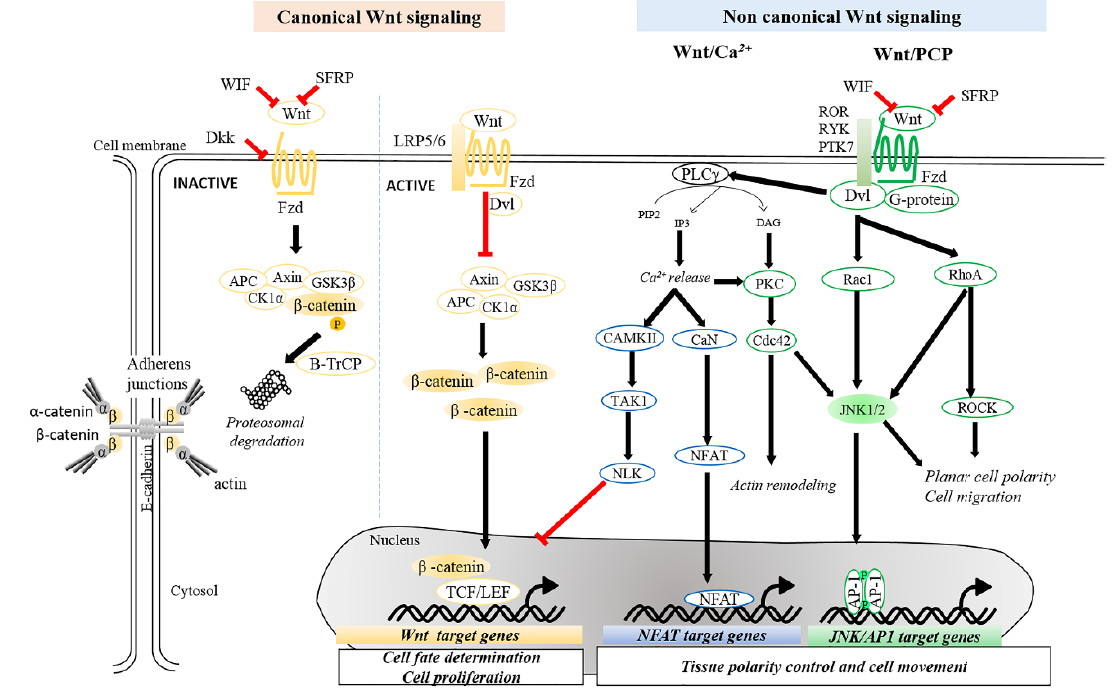
Figure 1. Overview of Wnt signaling pathways. This schematic diagram illustrates simplified canonical ( β -catenin-dependent) and non-canonical ( β -catenin-independent) Wnt signaling pathways. In the absence of Wnt, β -catenin is targeted by a destructive complex, composed of Axin, CK1 α , APC, and GSK3 β , for degradation. Upon Wnt binding to the receptor, recruited Dvl inhibits the degradation complex, which in turn stabilizes β -catenin. Stabilized β -catenin accumulates in the cytoplasm and then enters the nucleus where it acts as a transcriptional co-activator for TCF / LEF transcription factors to activate Wnt target genes. The transcriptional activation mediated by β -catenin can be suppressed by NLK, which is activated through non-canonical Wnt pathways. Non-canonical Wnt signaling is divided into Wnt / Ca 2 + and Wnt / PCP pathways. Wnt / Ca 2 + signaling is characterized by the release of intracellular Ca 2 + via activation of PLC γ converting PIP2 into IP3 and DAG, thus activating CaN, CaMKII or PKC. For Wnt / PCP pathways, Wnt ligand-receptor interaction activates small GTPases Rho or Rac, allowing cytoskeletal reorganization and modulating downstream JNK signaling. AP-1, activating protein-1; APC, adenomatous polyposis coli; CaMKII, Ca 2 + / calmodulin-dependent protein kinase II; CaN, calcineurin; CK1 α , casein kinase 1 α ; DAG, diacylglycerol; Dkk, dickkopf proteins; Dvl, dishevelled; Fzd, Frizzled; GSK3 β , glycogen synthase kinase 3 β ; IP3, inositol 1,4,5-triphosphate; JNK, c-Jun N-terminal kinase; TCF / LEF, T-cell factor / lymphoid-enhancing factor; LRP5 / 6, lipoprotein receptor-related protein 5/6; NFAT, nuclear factor of activated T-cells; NLK, nemo-like kinase; PCP, planar cell polarity; PIP2, phosphatidylinositol 4,5-bisphosphate; PKC, protein kinase C; PLCγ, phospholipase C γ; PTK7, tyrosine-protein kinase-like 7; ROCK, Rho-associated kinase; ROR, receptor tyrosine kinase-like orphan receptor; RYK, receptor-like tyrosine kinase; SFRP, secreted frizzled-related proteins; WIF, Wnt inhibitory factor.